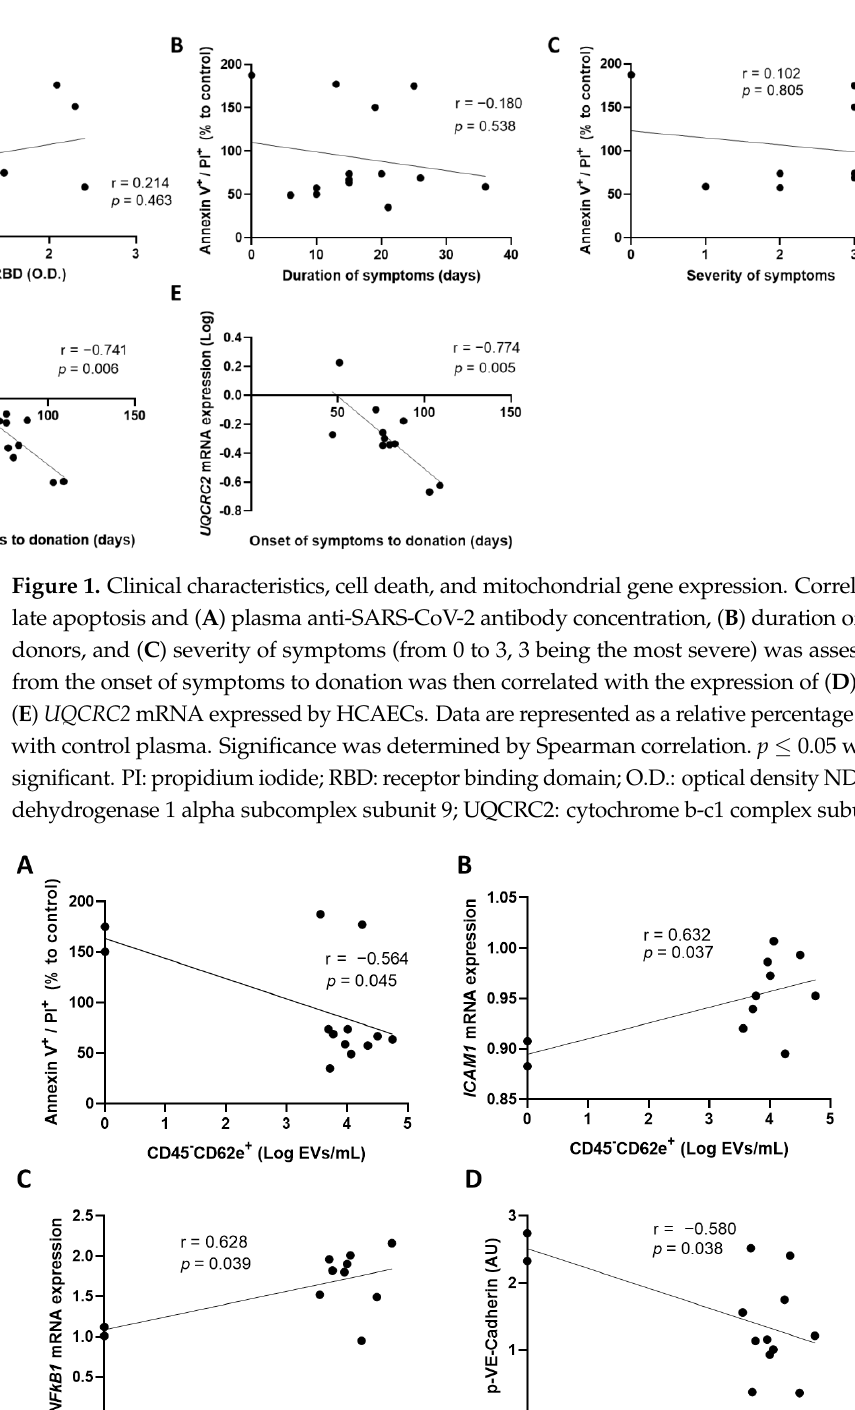
Figure 1. Clinical characteristics, cell death, and mitochondrial gene expression. Correlation be-